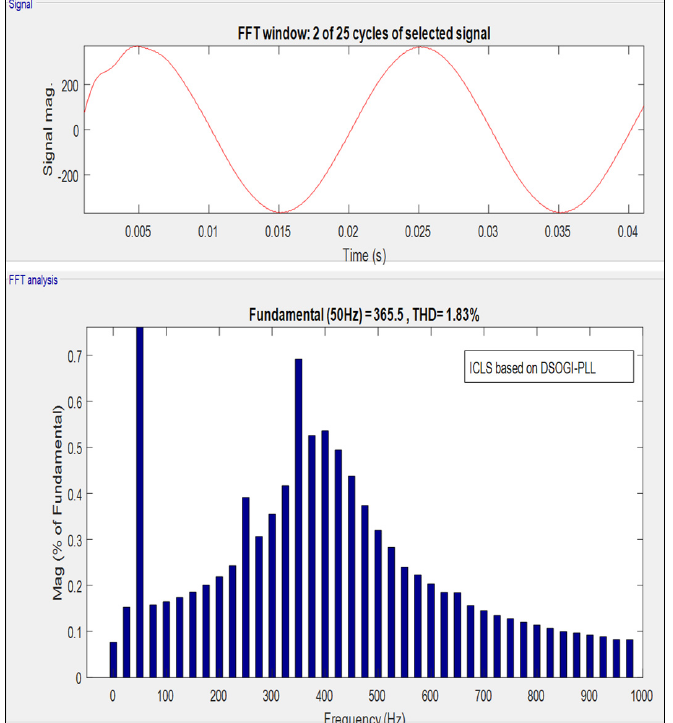
Figure 21. Case study 3 Three-phase grid voltages and current with ICLS-DSOGI-PLL.